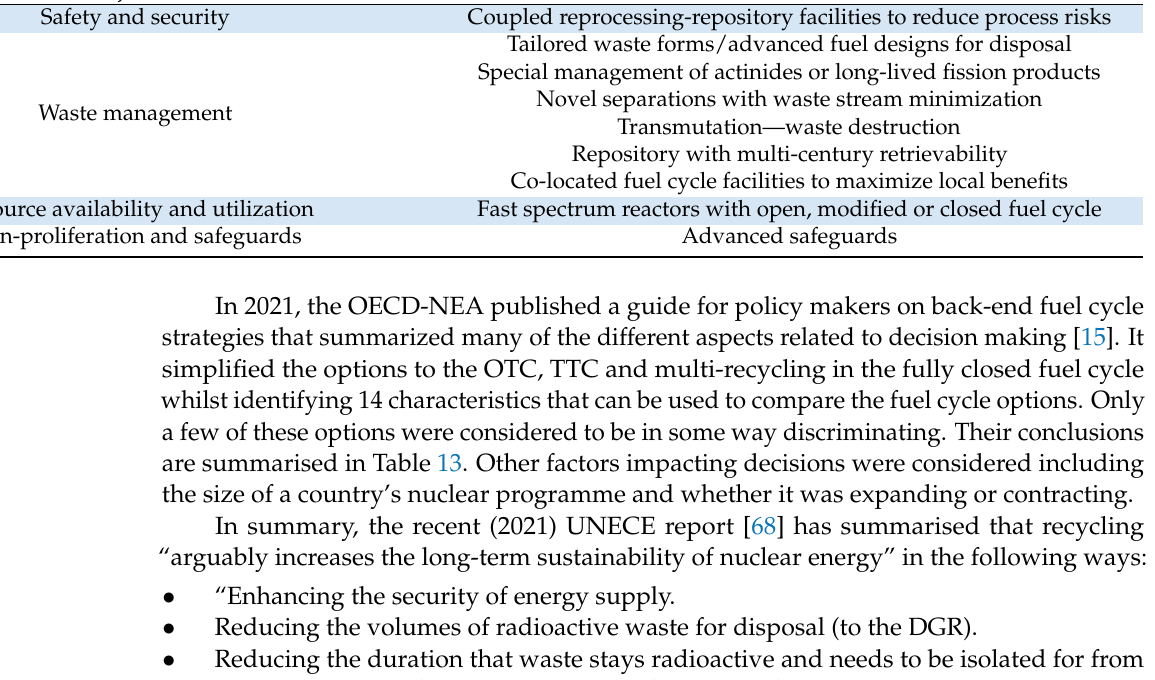
Table 12. Fuel cycle R&D needs synthesised by MIT to meet the objectives of AFCs [28].